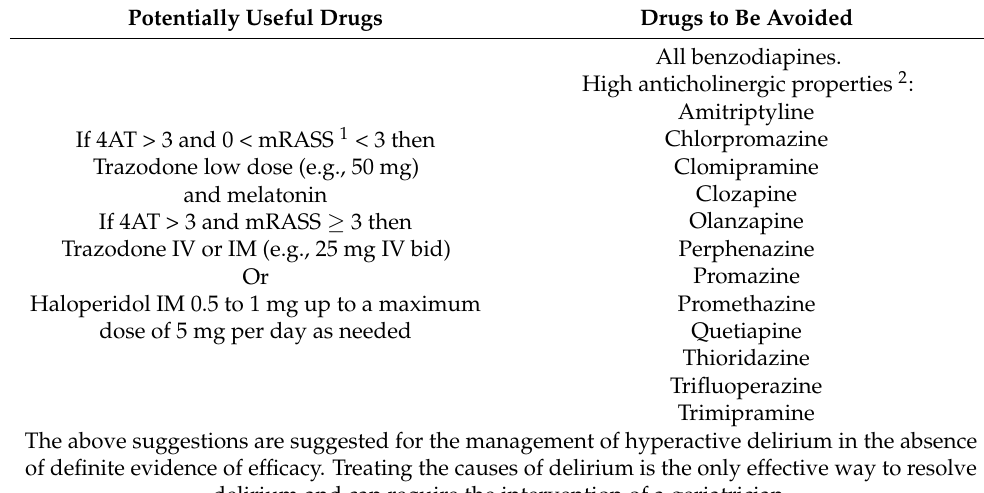
Table 2. Drugs used to manage hyperactive delirium (not alcohol-induced). Potentially Useful